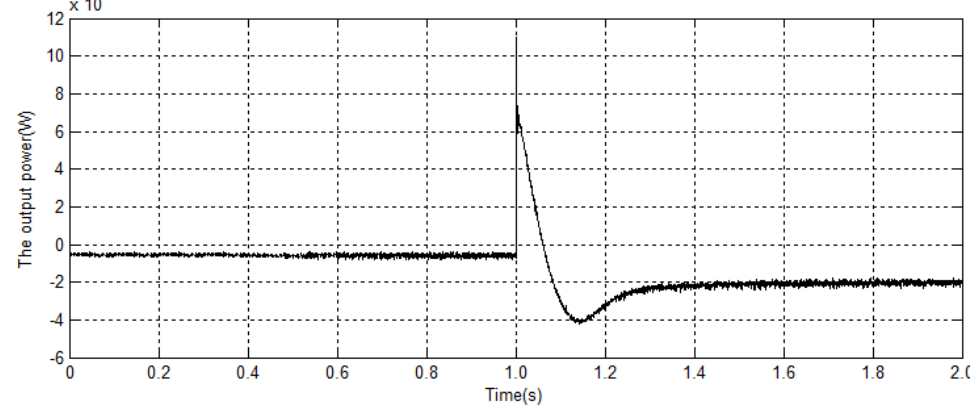
Figure 11. Simulation curve of output power.